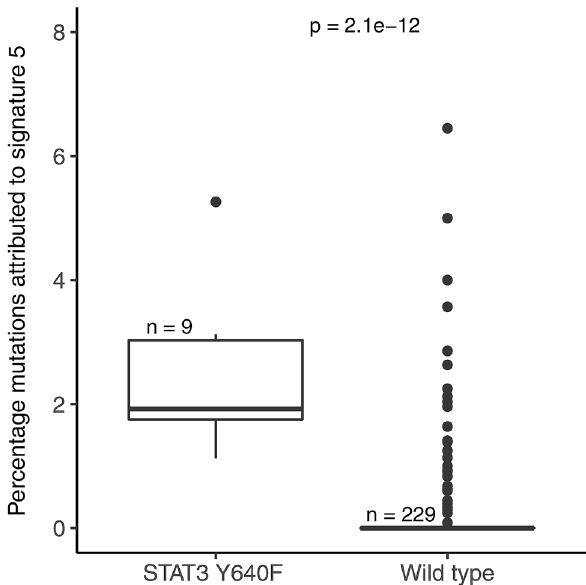
Figure 6. Patients with the STAT3 Y640F mutation showed significantly greater contribution of signature 5 to their mutational catalogue. Wilcoxon rank sum test was used to compare the contribution of each signature between the groups mutant or WT for a given mutation.